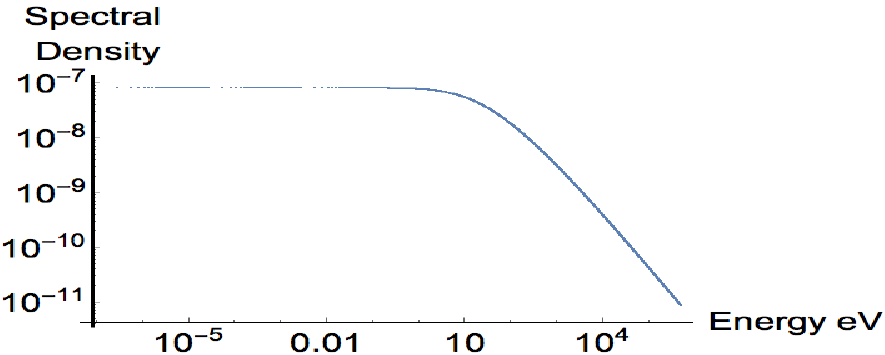
Figure 1. Plot of the log of the spectral density of the ground state Lamb shift from the group theoretical expression (29) versus the energy from 0 to 510 keV.